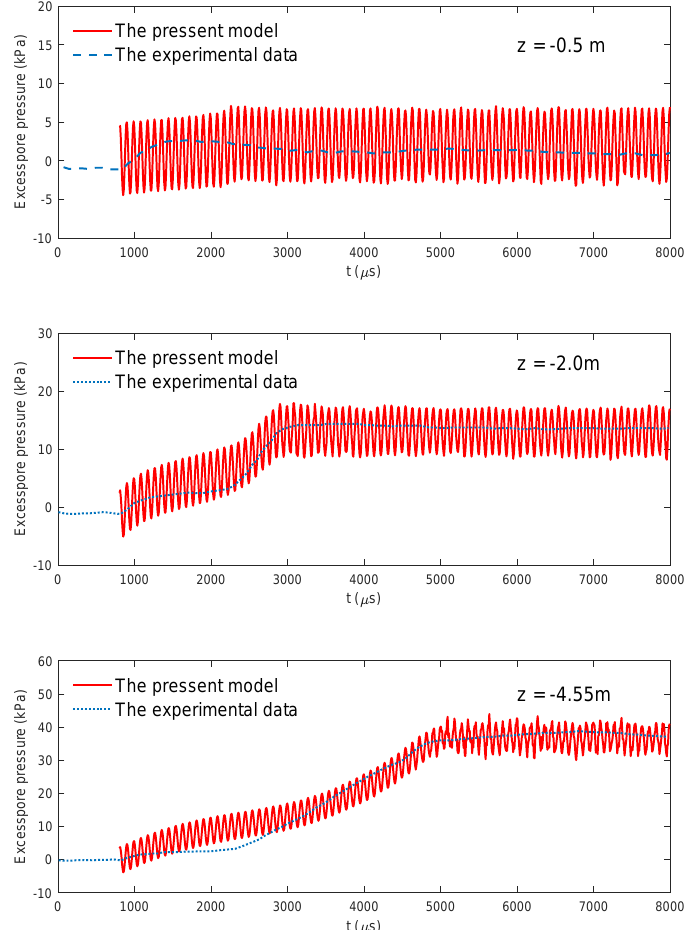
Figure 5. Comparison of the distribution of excessive pore pressure between the present model (solid line) and the centrifuge tests (dashed line)